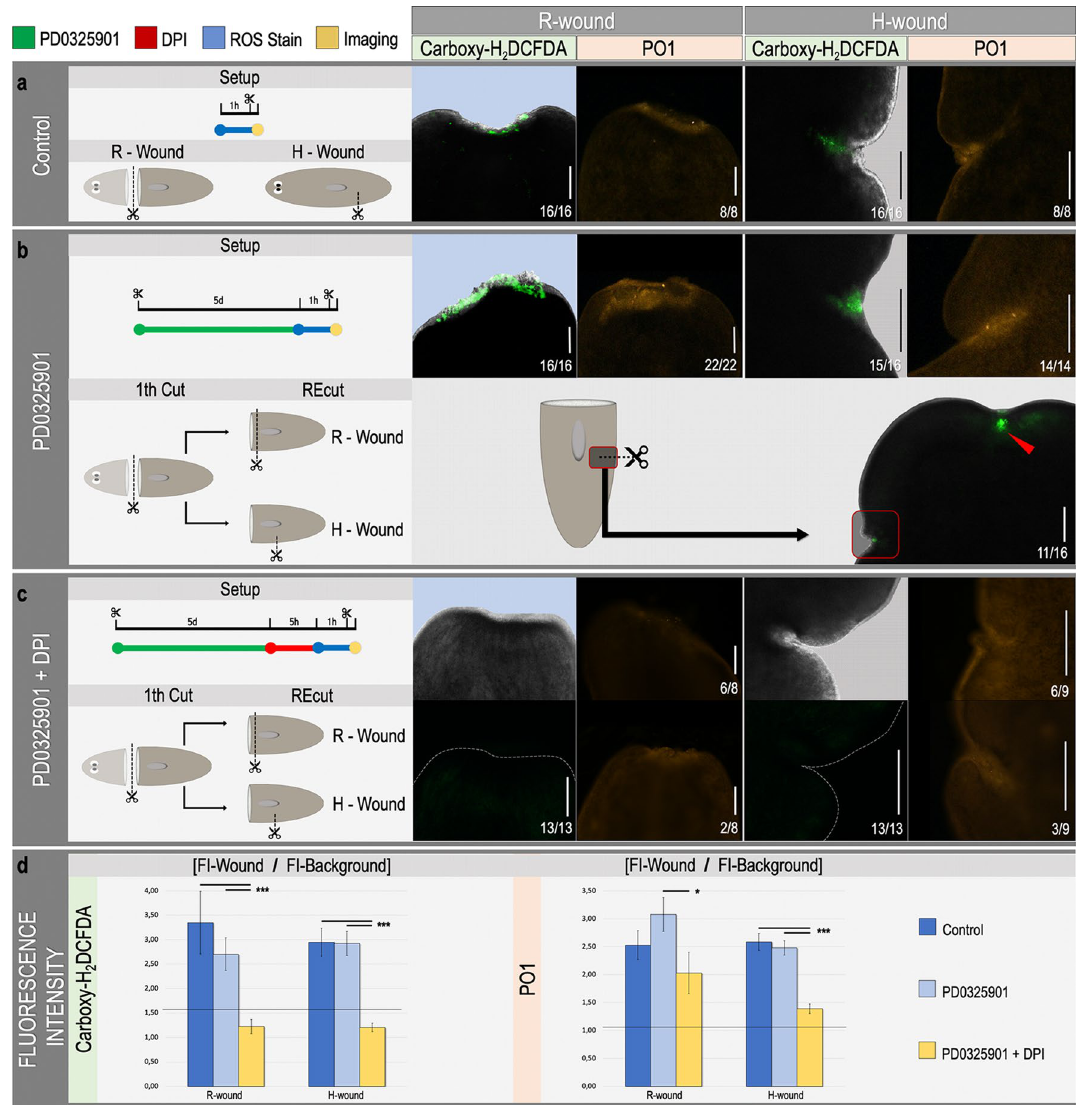
Figure 1. In vivo visualization of ROS production at the amputation site after re-wounding MEK-inhibited dormant fragments. For each condition, the experimental setup is displayed in the left panel. Color code as follows; green: MEK inhibition by PD0325901 (10 μM, 5 days), red: inhibition of ROS production by DPI (3 μM, 5 h), blue: ROS visualization procedure using carboxy-H 2 DCFDA as general ROS indicator or peroxy- orange-1 to specifically stain H 2 O 2 , yellow: imaging. Regenerative wound (R-wound) and healing wound (H-wound). All animals were imaged 30 min post amputation (MPA). A representative close-up merged image of bright field and fluorescence of either R-wounds or H-wounds after the general ROS stain is displayed on the left panel (green fluorescence), and a close-up image of the specific H 2 O 2 stain is displayed on the right (orange fluorescence) ( a ) ROS production at the site of an R-wound and an H-wound in controls. ( b ) ROS production at the amputation site of an R-wound and an H-wound in MEK-inhibited (PD0325901), dormant fragments. Lower panel in (b) shows an image of the site of the original R-wound applied before MEK- inhibition (red arrowhead) together with the newly applied H-wound (red square). ( c ) ROS production after re-wounding (R-wound and H-wound) MEK-inhibited and DPI exposed dormant fragments. Because of the strongly reduced fluorescence in (c), the close-up of the wound site is shown in bright field (upper left panels) and fluorescence (lower left panels) separated for in the general ROS stain while the H 2 O 2 stain allows to only display the fluorescence images (on the right panels). The dotted, white lines indicate the border of the wound site. Scale bars 100 µm. ( d ) Relative fluorescence intensity of the wound region. Color code as follows; dark blue: control (representing data of panel A), light blue: MEK inhibition (representing data of panel B), yellow: MEK inhibition + DPI (representing data of panel c). Left panel; fluorescence intensity representing general ROS production visualized with carboxy-H 2 DCFDA. Right panel; fluorescence intensity representing hydrogen peroxide production visualized with peroxy orange 1 (PO1). Statistical significance is indicated by: * p < 0.05; ** p < 0.01; *** p <